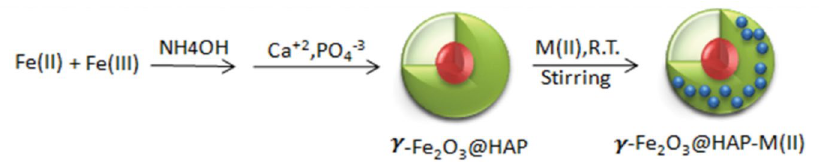
O @HAp (a) and M(II) doped γ-Fe 2 3 Fe(II) (c), Co(II) (d), Ni(II) (e), Cu(II) (f), Zn(II)